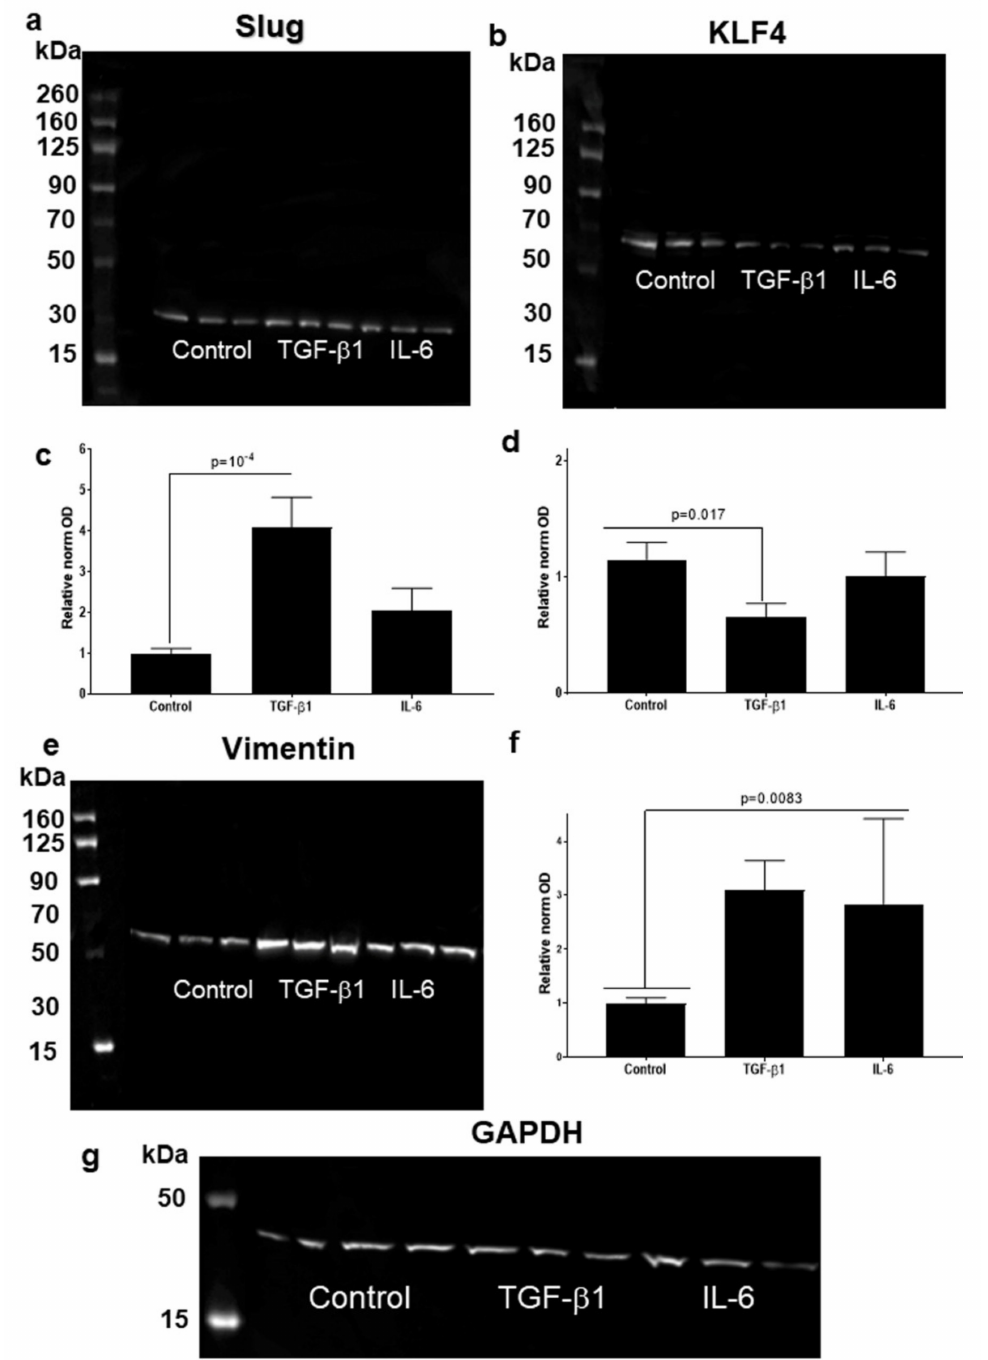
Figure 7. Western blot detection of Slug ( a ), KLF4 ( b ) and vimentin ( e ) proteins in SCC-25 cells in control, 1 ng/mL TGF- β 1 and in 50 ng/mL IL-6 treated conditions. Both Slug ( c ) ( p = 10 − 4 by Kruskal-Wallis test and Dunn’s multiple comparison) and vimentin ( f ) ( p = 0.0083 Kruskal-Wallis test and Dunn’s multiple comparison) showed significant upregulation by TGF- β 1 treatment ( a , c , e , f ), whereas the KLF4 protein levels ( b , d ) were statistically significantly reduced ( p = 0.017 by unpaired t -test compared to control). IL-6 upregulated Slug ( c ) and downregulated KLF4 ( b , d ), but it was not statistically significant. Vimentin showed a significant increase ( p = 0.0083 Kruskal-Wallis test and Dunn’s multiple comparison) by IL-6 treatment ( e , f ). Four western blot membranes were acquired digitally, and the band optical densities (ODs) of proteins of interest and of loading control